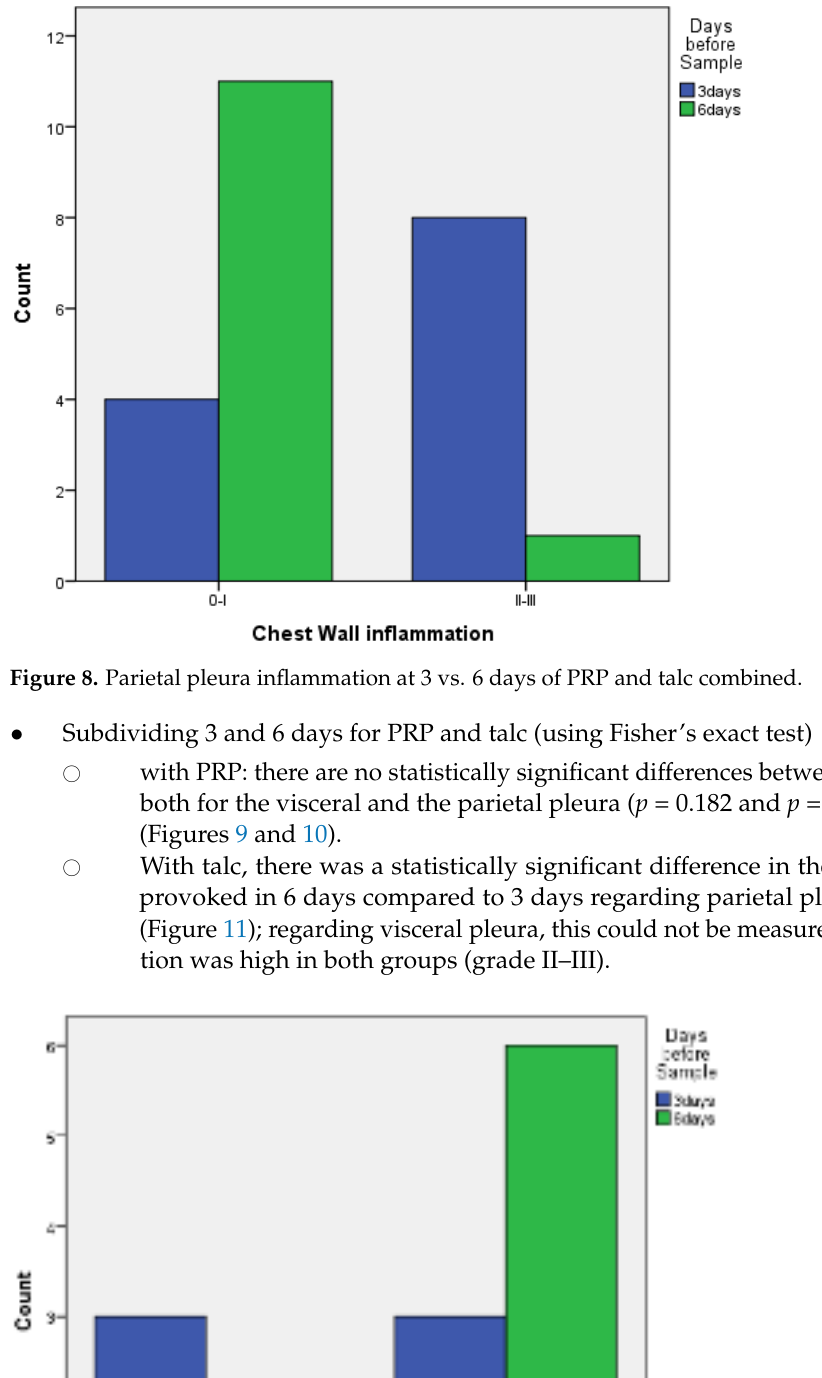
Figure 7. Visceral pleura inflammation at 3 vs. 6 days of PRP and talc combined.